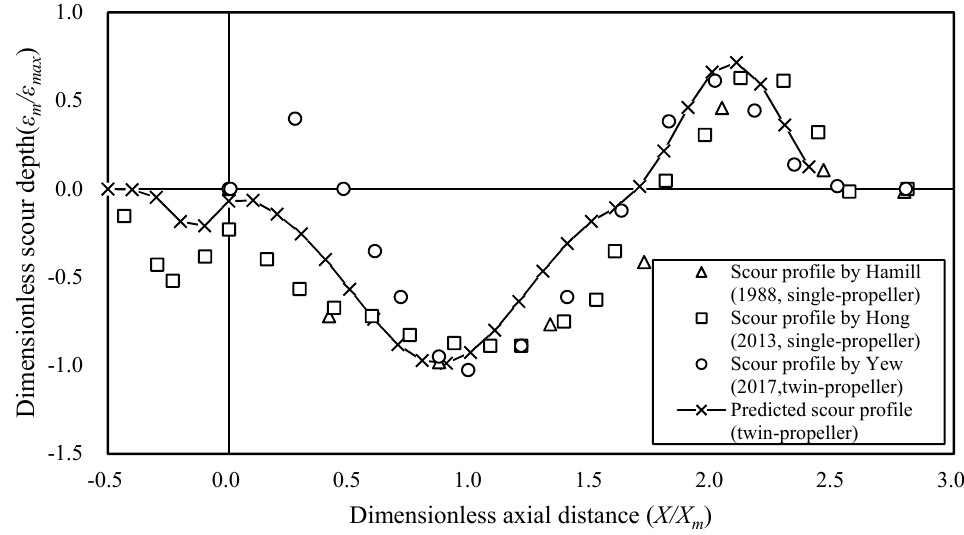
Figure 14. Comparison between the predicted equation and previous research.